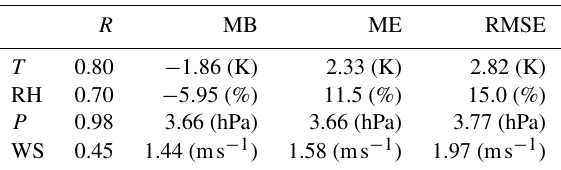
Table 3. Statistical performances of the hourly near-surface meteo- rology simulated by the WRF